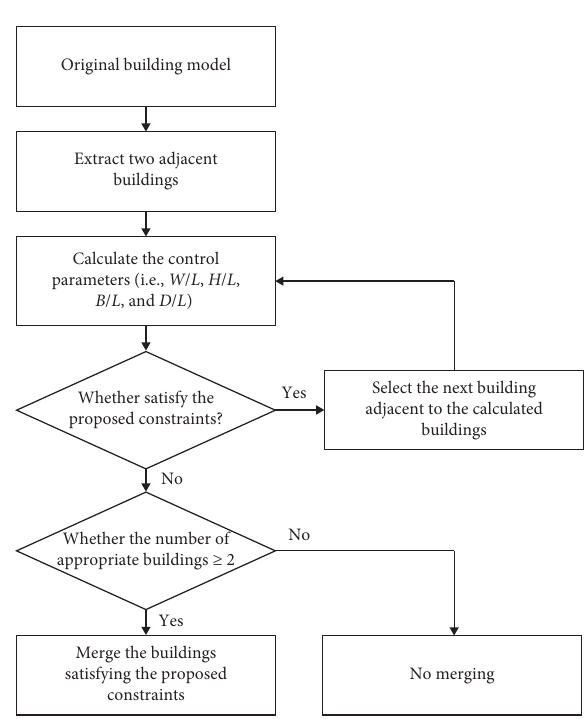
Figure 8: The simplification process of the building group model.